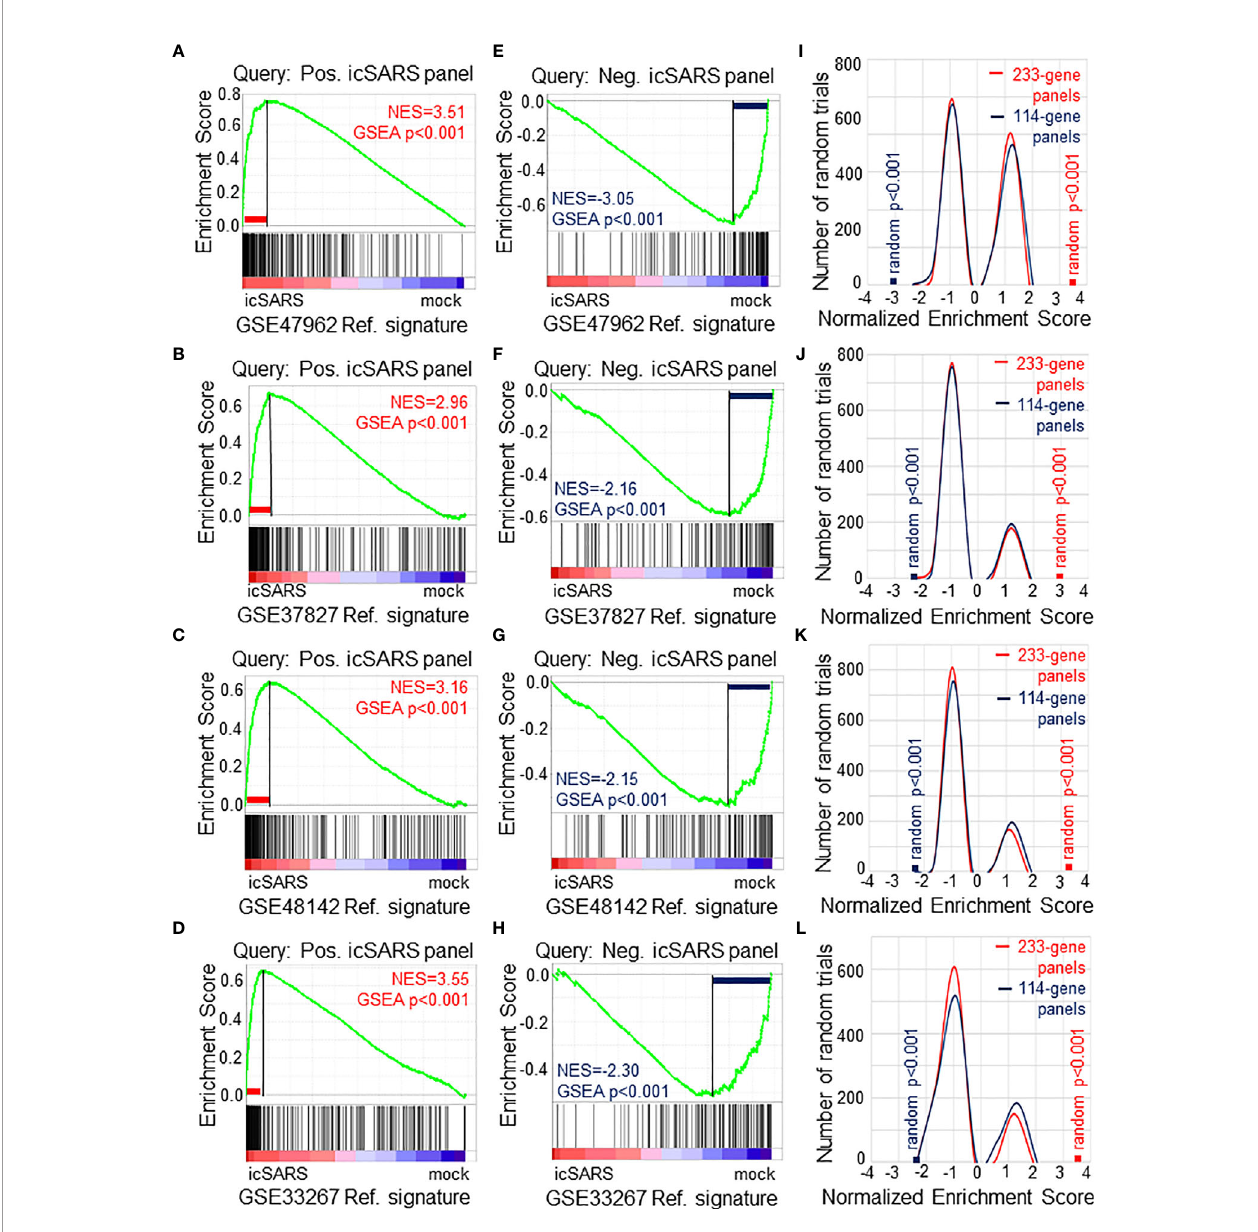
FIGURE 2 | Veri fi cation of icSARS Gene Panels in Independent Datasets. (A) Gene Set Enrichment Analysis (GSEA) calculated enrichment, as determined by normalized enrichment score (NES), between the positive icSARS gene panel and the GSE47962-derived icSARSvsmock gene signature. (B) GSEA between the positive icSARS gene panel and GSE37827-derived icSARSvsmock gene signature. (C) GSEA between the positive icSARS gene panel and GSE48142-derived icSARSvsmock gene signature. (D) GSEA between the positive icSARS gene panel and GSE33267-derived icSARSvsmock gene signature. (E) GSEA between the negative icSARS panel and the GSE47962-derived icSARSvsmock signature. (F) GSEA between the negative icSARS panel and the GSE37827-derived icSARSvsmock signature. (G) GSEA between the negative icSARS panel and the GSE48142-derived icSARSvsmock signature. (H) GSEA between the negative icSARS panel and the GSE33267-derived icSARSvsmock signature. (I) Distribution plot of NES from 1000 randomly generated gene panels (individual queries) compared to the GSE47962-derived icSARSvsmock signature. (J) Distribution plot of NES from 1000 randomly generated gene panels compared to the GSE37827- derived icSARSvsmock signature. (K) Distribution plot of NES from 1000 randomly generated gene panels compared to the GSE48142-derived icSARSvsmock signature. (L) Distribution plot of NES from 1000 randomly generated gene panels compared to the GSE33267-derived icSARSvsmock leading-edge from mouse lung samples ( Figure 3D ): IFN − induced protein with tetratricopeptide repeats 3 (human Table 5 ), our meta-analysis approach found nine of the 51 genes veri fi ed across human lung cultures were also in the